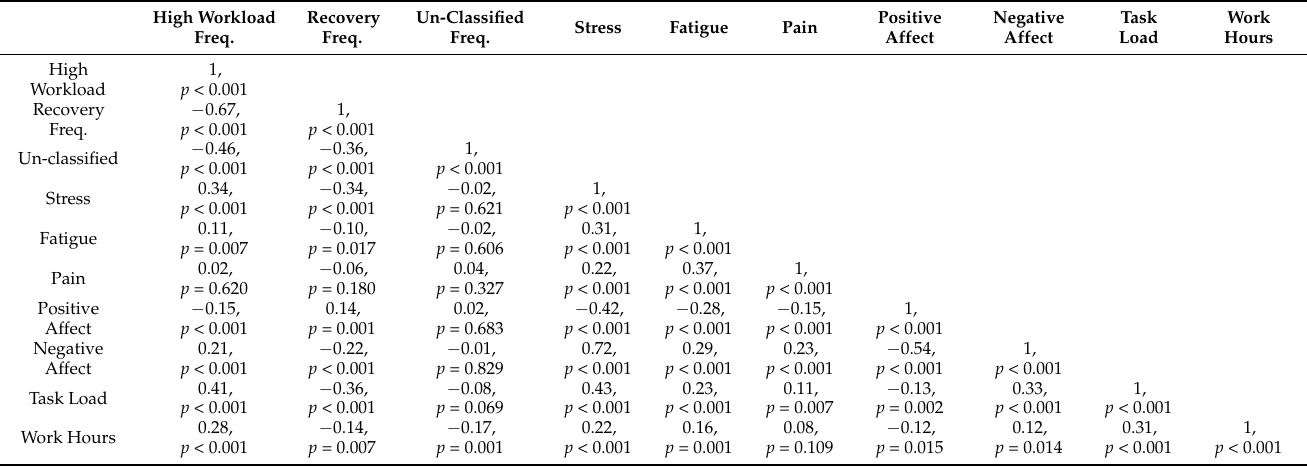
Table A2. Within-person intercorrelation